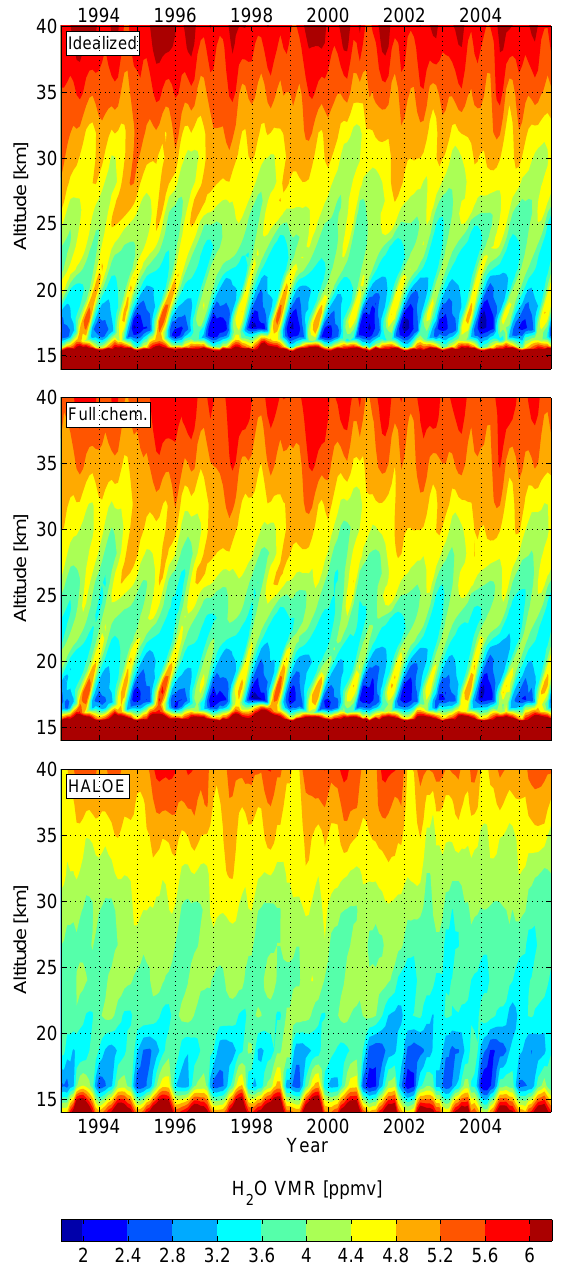
Fig. 1. Comparison of tropical (20 ◦ N to 20 ◦ S) water vapor mix- ing ratios (“tape recorder”) of idealized setup (top), full chemistry setup (middle) and HALOE observations (bottom, Grooß and Rus- sell,